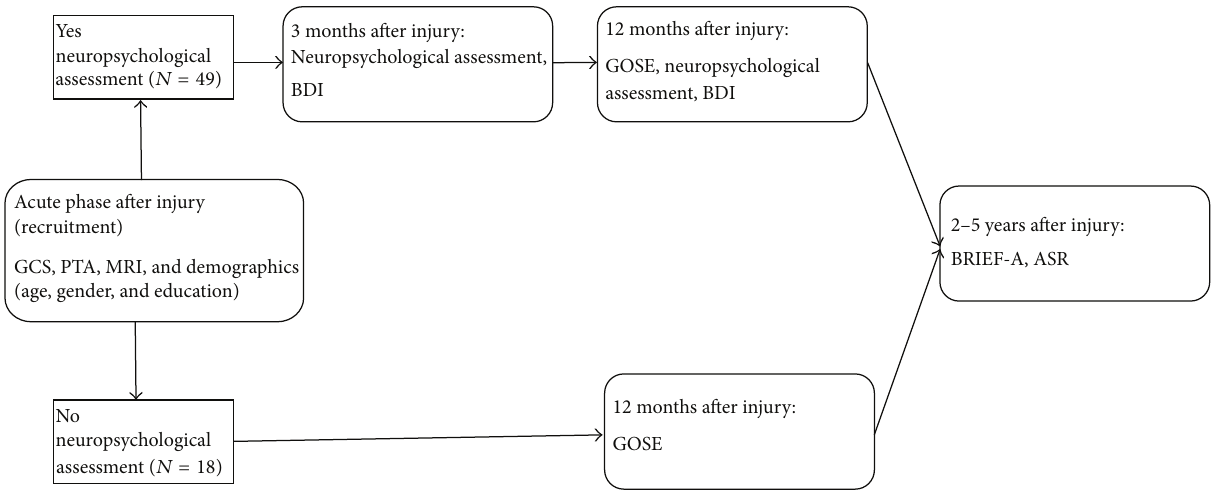
Figure 2: Timeline displaying the time points during data collection and the assessments for this